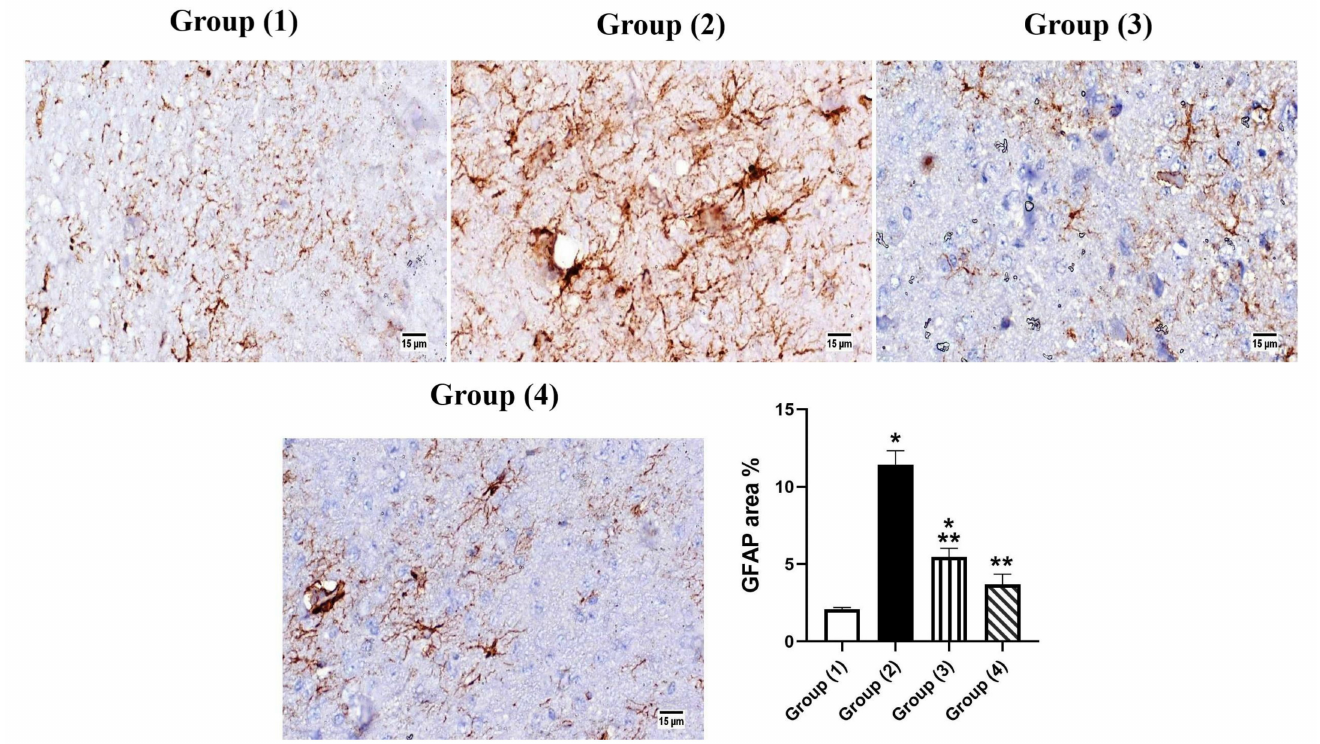
Figure 9. Photomicrograph immunohistochemistry of GFAP expression in brain tissue. Group (2) shows marked expression of GFAP; however, morphological difference between the two treated groups was not observed. The graph shows that the area % of GFAP was significantly elevated in group (2); values are expressed as means ± SE. Significant difference was considered at p < 0.05. *: Statistically significant difference from the normal group at p < 0.05, **: Statistically significant difference from the positive control group (STZ, 3 mg/kg) at p <